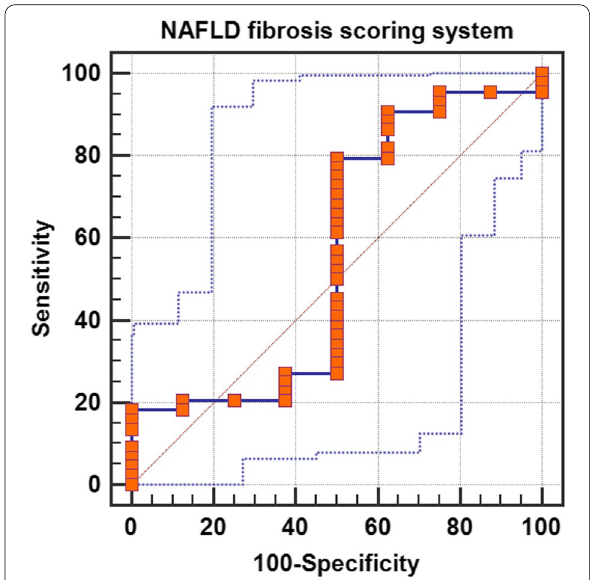
Fig. 2 The ROC (receiver operating characteristic) curve for the best cutoff value of the NAFLD fibrosis scoring system to predict significant coronary